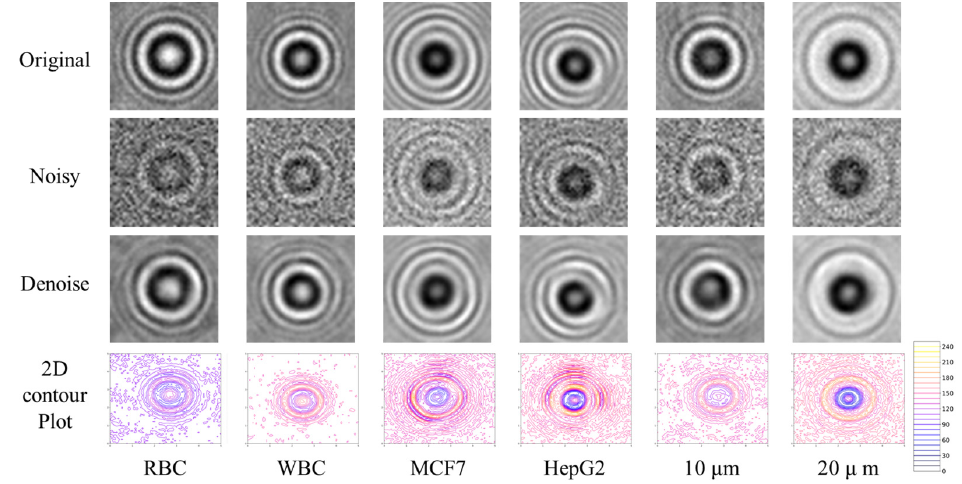
Figure 2. Reconstructed results from the optimized CNN. The top row is the original LSIT image (cell diffraction pattern) of a single RBC, WBC, MCF7, HepG2, 10 µm beam, and 20 µm bead. The second row is the noisy version (with variance 100) of the corresponding original images (cell diffraction pattern). The third row is the denoised version of the corresponding original images (cell diffraction pattern) from the noisy image (cell diffraction pattern). The fourth row is the 2D intensity contour plot of the original image (cell diffraction pattern) to show the unique signature of each of these cell lines.